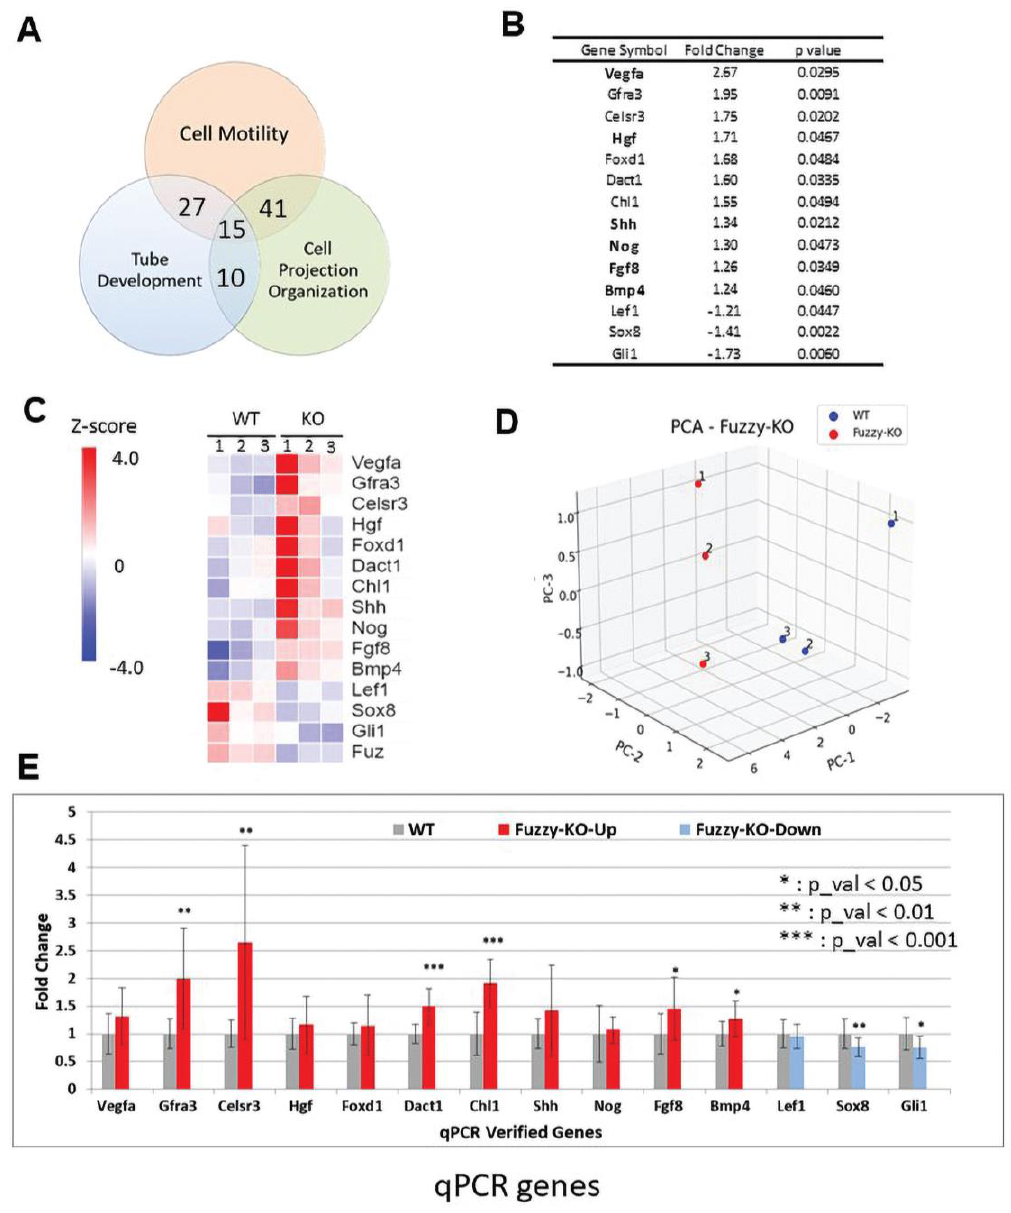
Figure 6. Specific genes with modified expression in Fuzzy − / − kidneys. ( A ) Venn diagram showing overlap between the genes in each two and all three GO groups. ( B ) List of genes chosen for further validation; in bold are the genes that overlap in 3 GO groups. ( C ) Heatmap of the selected genes; the last row is expression of Fuzzy mRNA; upregulated genes (UP) are depicted in red, downregulated (DOWN) genes are depicted in blue. ( D ) Principal component analysis for each of the 3 samples per genotype using 14 selected genes. Each sample per genotype is designated as 1, 2 or 3; the samples numeration in both PCA and heatmap is identical. Note a separation between the wildtype and Fuzzy −/− samples. ( E ) Validation of expression of 14 genes by quantitative PCR. Each biological sample was prepared from 1 – 2 kidneys from a E14.5 embryo, 4 embryos per genotype were used; the experiment was repeated twice. * p < 0.05; ** p < 0.01; *** p <